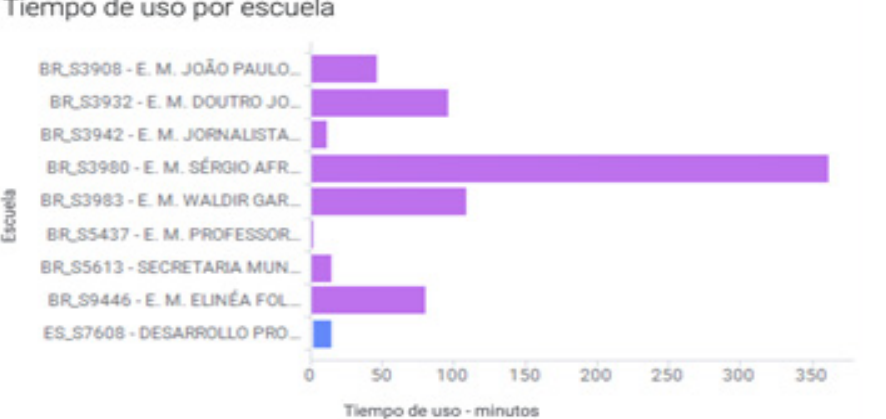
Figure 10. Digital resources usage time per educational institution.